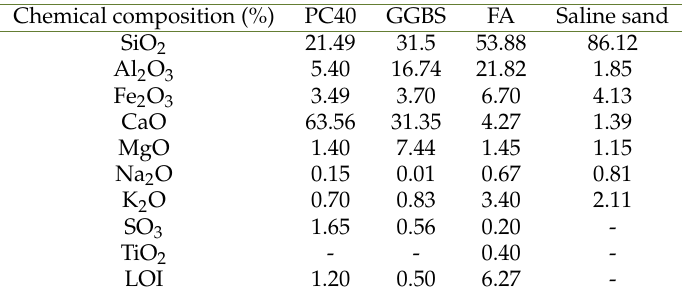
Table 1. Chemical compositions of materials used.